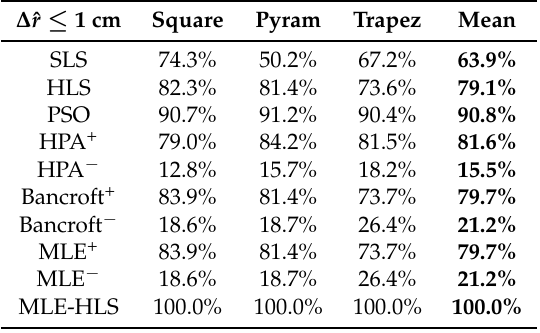
Table 2. Percentage of positions analysed located with a radius error ∆ ˆ r lower than 1 cm under theoretical conditions for each algorithm and antenna array configuration. SLS, standard least squares; HPA, hyperbolic positioning